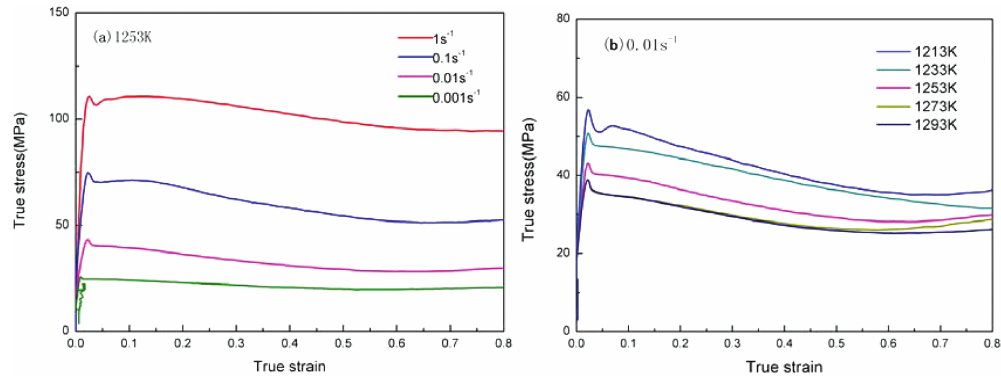
Figure 2: True stress – strain curves of BT25y alloy at different strain rates and temperatures: (a) 1,253 K; (b) 0.01 s – 1 .